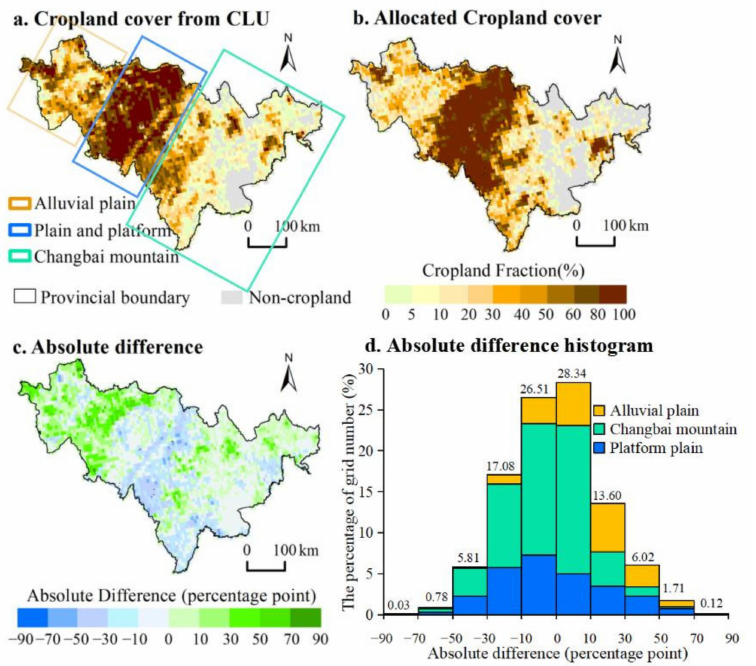
Figure 8. A comparison of cropland cover obtained from the CLU database in 1980 and the cropland cover allocated using the settlement density